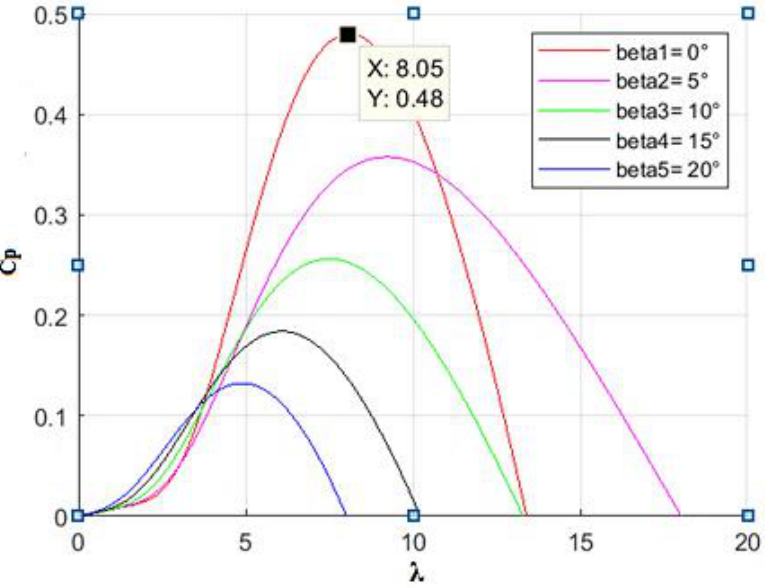
Figure 3. Cp-λ characteristics, for different values of the pitch angle